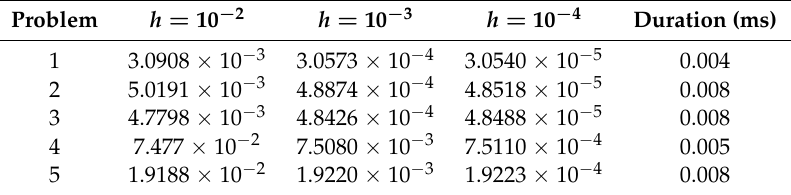
Table 1. Absolute errors at the last mesh point over [ 0,1 ] with ν = 1 √